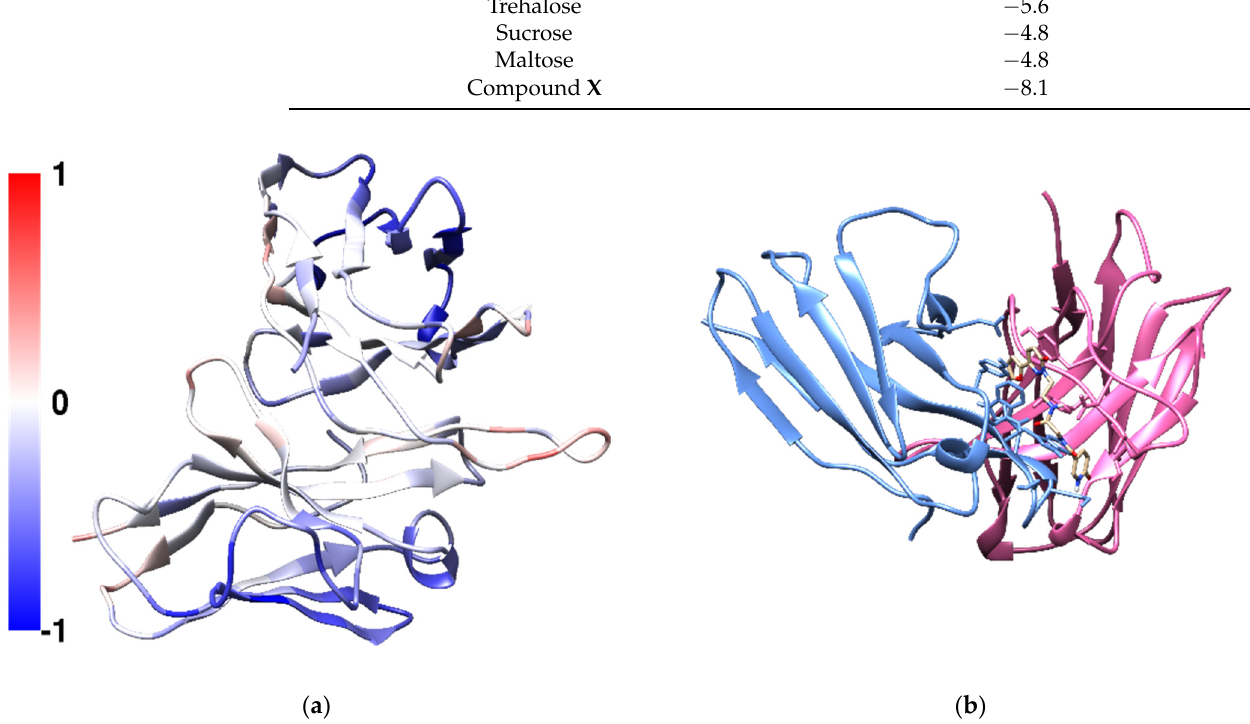
Figure 4. ( a ) Visual representation of the SAP calculation results for mAb1 Fv fragment. The mole- cule is oriented with the heavy chain shown at the top of the model and the light chain at the bottom with CDRs at the right side. Residues with positive and negative SAP scores were coloured in red and blue, respectively. In general, the light chain is more hydrophilic than the heavy chain with the CDR3 on the heavy chain exhibiting the highest SAP score. ( b ) The configuration of Compound X docked to mAb1 Fv fragment with a predicted binding affinity of − 8.1 kcal/mol. The heavy chain was coloured in pink and the light chain was coloured in light blue.